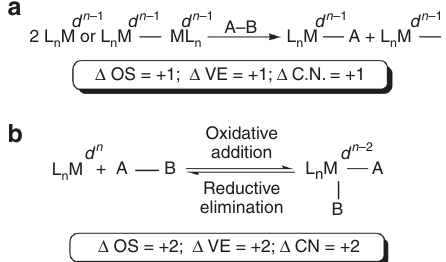
Fig. 1 Principal types of oxidative addition reaction observed with d-block metals. a Two single-electron oxidations of an A – B bond of a substrate at either two transition metal centres (M) or a binuclear complex resulting in changes of +1 to the oxidation state (OS), valence electron (VE) and coordination number (CN) of the metals and a reduction of d-electrons by one. b Classical two-electron oxidative addition, the reverse of which is reductive elimination, of an A – B bond with a single transition metal centre, resulting in changes of +2 to the metal OS, VE, CN, and a reduction of d- electrons by